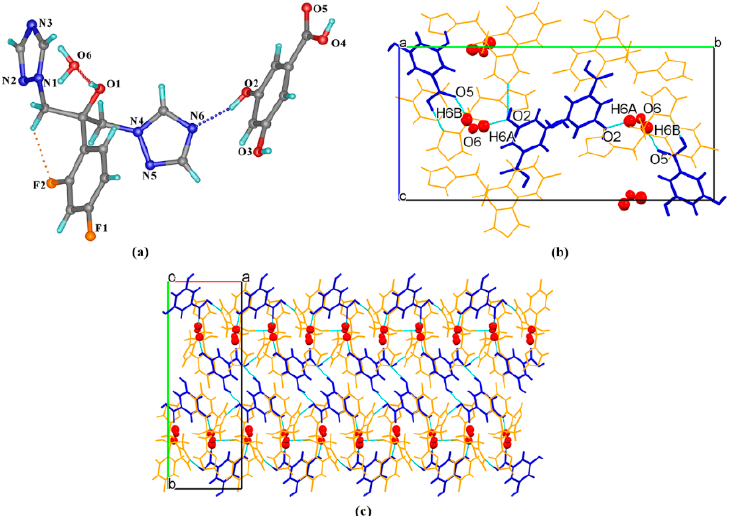
Figure 5. ( a ) Hydrogen-bonding interactions in an asymmetric unit; ( b ) interactions between FLZ, 35DHB, and water molecules; ( c ) 3D structure viewed along the c-axis with water molecules in space-filled mode, FLZ in wire-framed mode. a,b,c in subfigure ( b ) and ( c ) represents the three axes of the